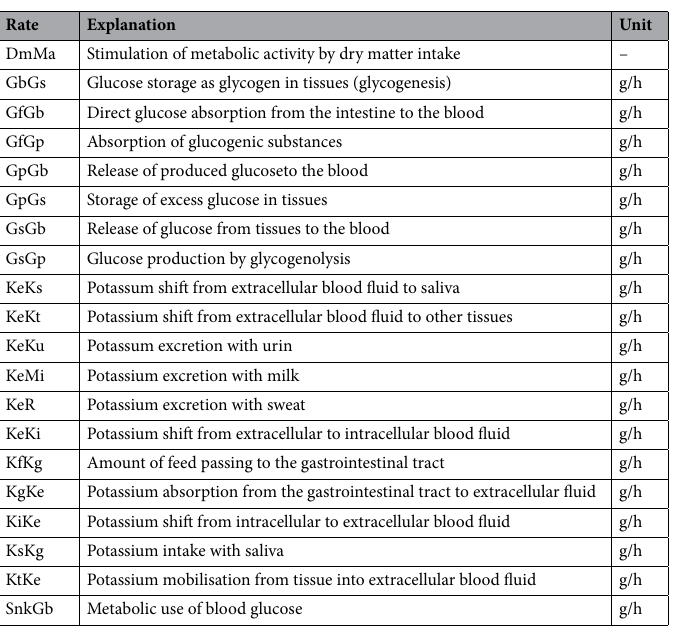
Table 2. Rates and their units in the model for potassium balance in dairy